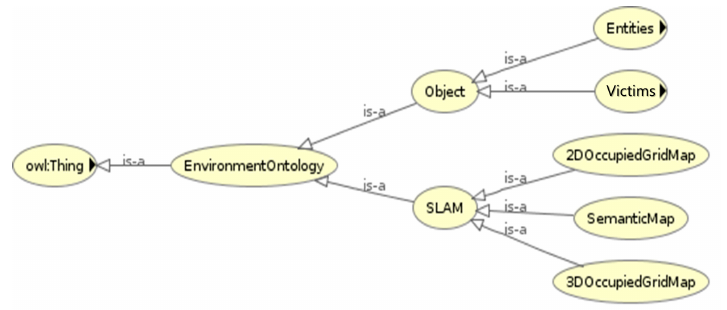
Figure 5. The environment ontology shown in Protégé.